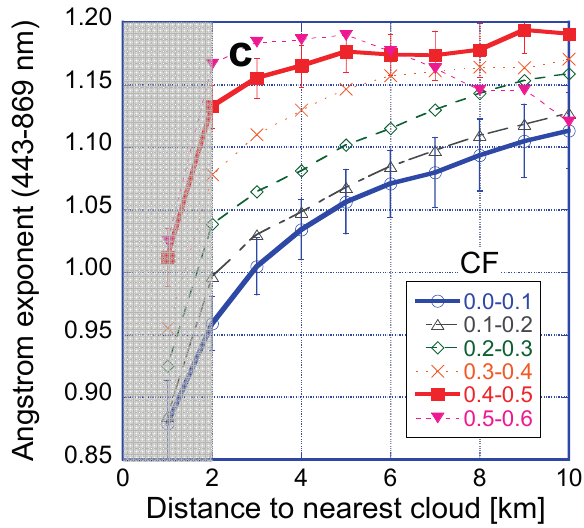
Figure 3. Impact of distance to cloud for two cloud fraction (CF) ranges. All QA flags are used to screen the data except for the straylight flag. ( a ) Number of pixels; ( b ) aerosol optical thickness; ( c ) Angstrom exponent. In this and subsequent figures, the results for areas less than 2 km away from clouds are shaded because low sample numbers and a higher risk of cloud contamination makes them less reliable. In this and subsequent figures, the error bars indicate the uncertainties due to interannual variability, estimated from the spread of results for individual years. While this figure includes all CF bins below 0.6 (statistics get uncertain for higher CFs), for clarity, subsequent similar figures will include only the 0.0–0.1 and 0.4–0.5 bins (blue and red